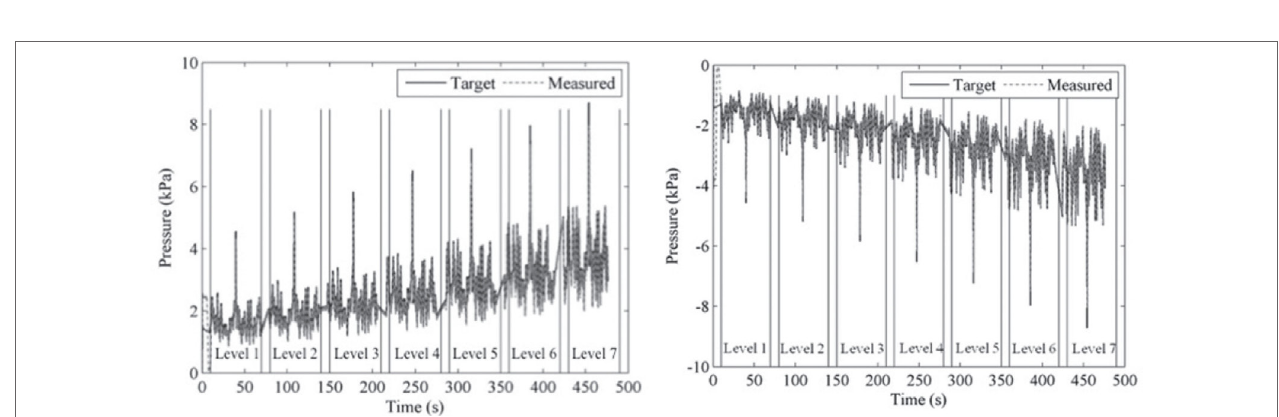
FigUre 3 | national institute of standard and Technology database wind tunnel model and tap locations: (a) the location of Tap 3716 where the maximum C p was recorded and the incident wind direction; and (B) the time history of the C p data for Tap 3716